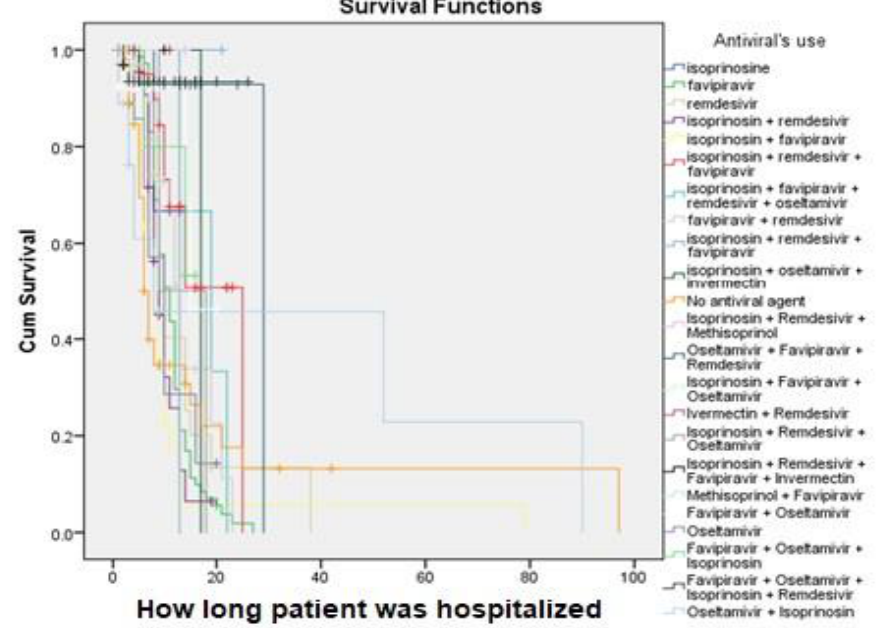
Figure 4. Kaplan – Meier survival analysis of the antiviral agents used.